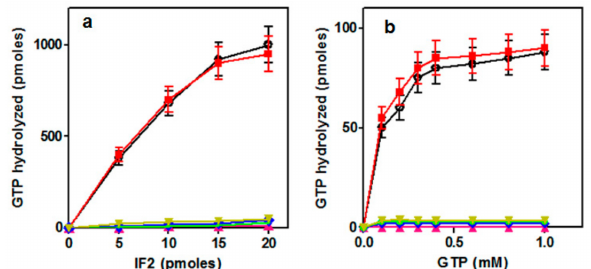
Figure 3. Ribosome-dependent GTP hydrolysis by IF2. ( a ) Amount (pmoles) of GTP hydrolyzed after 20 min incubation at 45 ◦ C of 100 µ M GTP with the increasing amounts (abscissa) of the individual IF2 variants in the presence of G. stearothermophilus 30S and 50S ribosomal subuniuts (15 pmoles each); ( b ) amount (pmoles) of GTP hydrolyzed by one pmole of IF2 after incubation of 10 pmoles